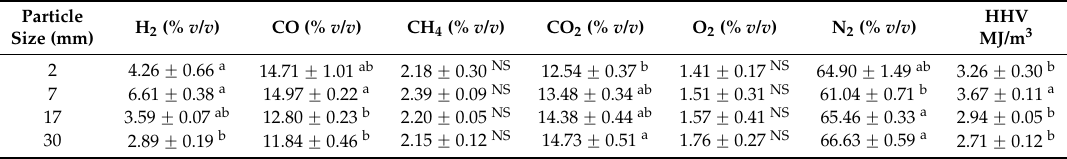
Different superscripts indicate significant differences ( p < 0.05). NS—not significantly different.